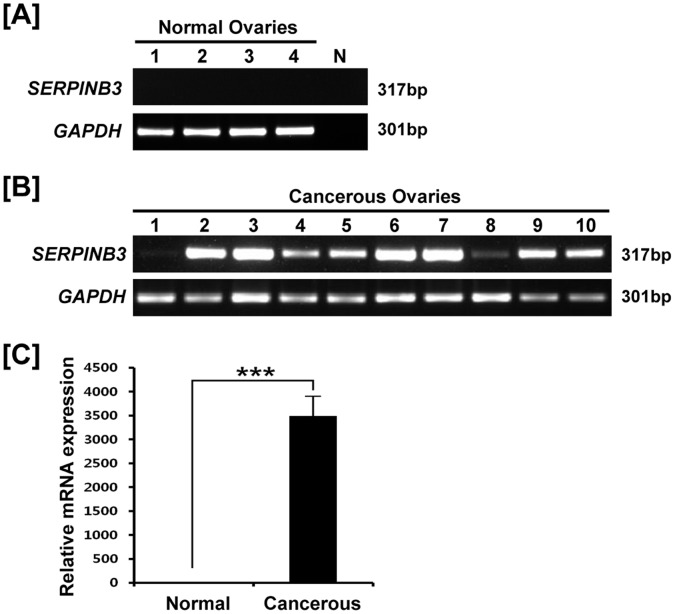
Expression and quantitation of SERPINB3 mRNA in normal and cancerous ovaries of laying hens.RT-PCR analysis was performed using cDNA templates from chicken SERPINB3 and GAPDH-specific primers. [A] Lanes 1 to 4 show four different normal ovaries and N is negative control. [B] Lanes 1–10 show 10 different cancerous ovaries. [C] Quantitative RT-PCR analysis was performed using cDNA templates from normal and cancerous ovaries of laying hens (mean ± SEM; P<0.01).